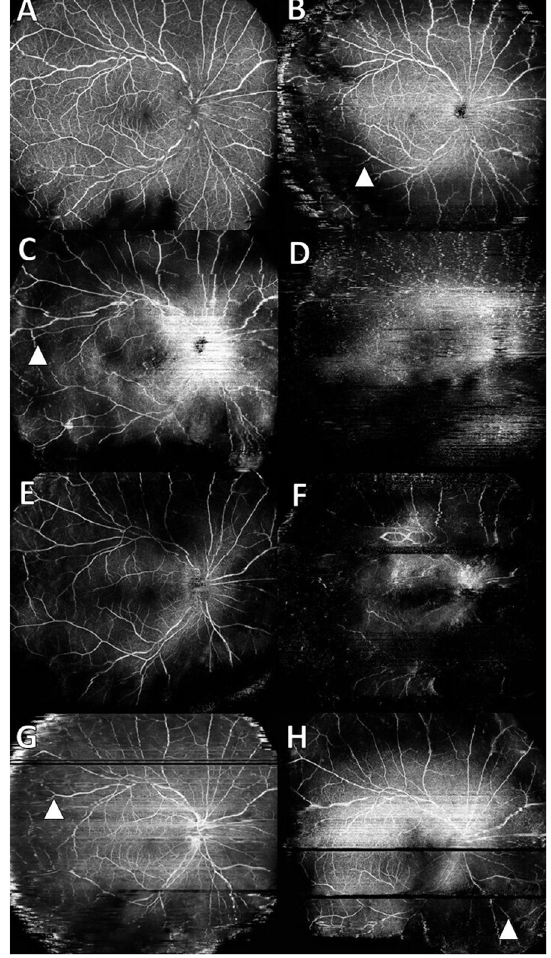
Fig. 2 En-face ultra-widefield optical coherence tomography angiography (OCTA) images of the right eye for Case 1 ( A - H ). Over the course of 1 year, the peripheral avascular area expanded from the arcade vessels. A The first visit, B 1 month after surgery, C 2 months later, D 3 months later, E 6 months later, E 10 months later, F 1 year later, G After 1 year and 5 months (white arrow head: NPA) The images have several